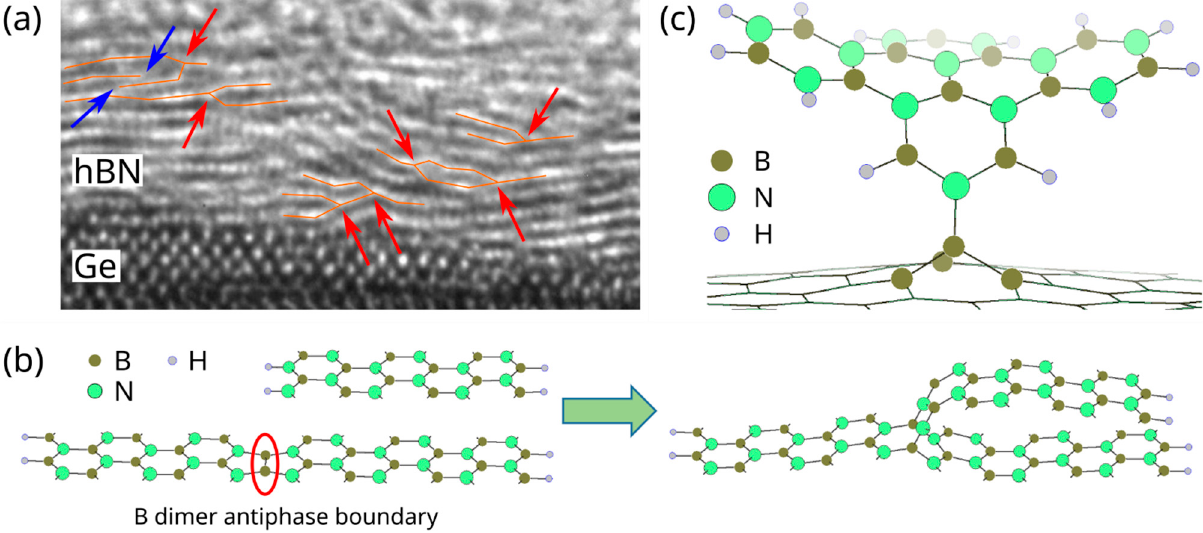
Figure 7. ( a ) Cross-section HRTEM image showing multiple bifurcations (red arrows), possibly as a product of the process shown in ( b ), as well as two detached layers (blue arrows). The hBN layers have been partially highlighted as a guide to the eye. ( b ) Initial state of separate, parallel hBN ribbons and relaxed final state of hBN ribbons attached at the former B dimer antiphase boundary. ( c ) Nucleation of a new hBN layer at a B N point defect.